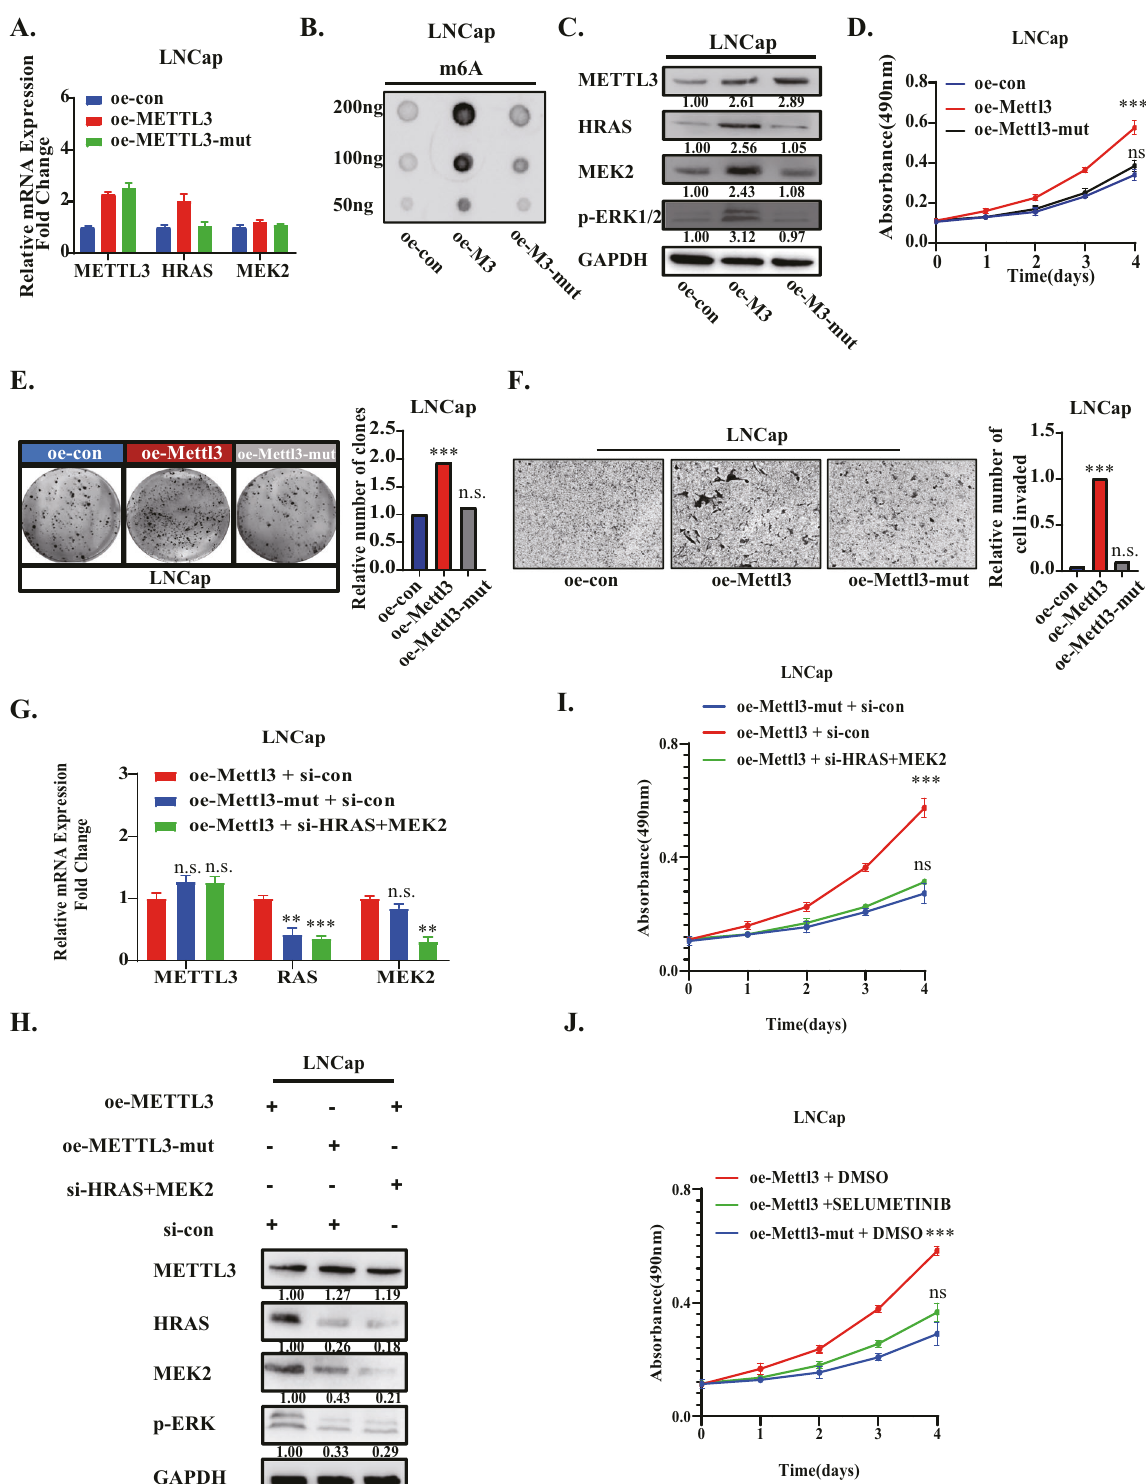
Previous reports showed that p-ERK1/2 was up-regulated in enzalutamide-resistant cells [22, 23]. We detected the level of METTL3 and m 6 A in enzalutimide-resistant cells and sensitive cells, and found that the level of METTL3 and m 6 A in drug-resistant cell lines was signi fi cantly up-regulated (Fig. 6C, D). We also constructed stable cell lines by lentivirus(sh-METTL3). Then, we tested